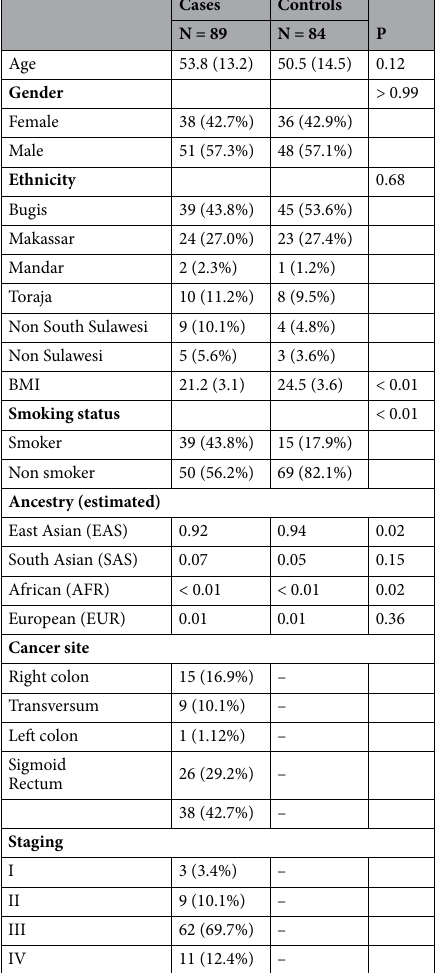
Table 1. Characteristics of South Sulawesi colorectal cancer cases and